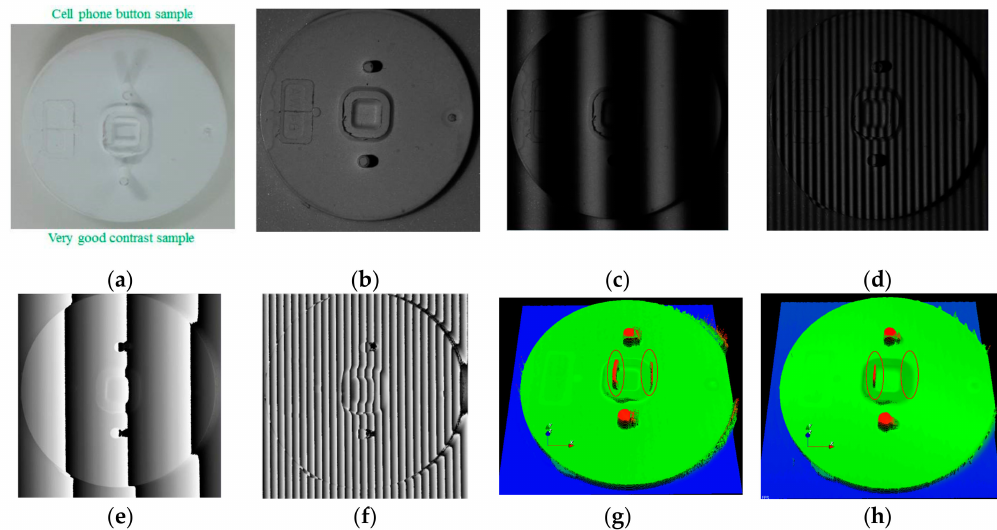
Figure 14. Measurement results of cell phone button target: ( a ) digital image of cell phone button target; ( b ) captured image without fringe; ( c ) captured image with fringe pitch 121; ( d ) captured image with fringe pitch 12; ( e ) wrapped phase map of fringe pitch 121; ( f ) wrapped phase map of fringe pitch 12; ( g ) 3D profile measured using MFPS; ( h ) 3D profile measured using NCCMFPS.